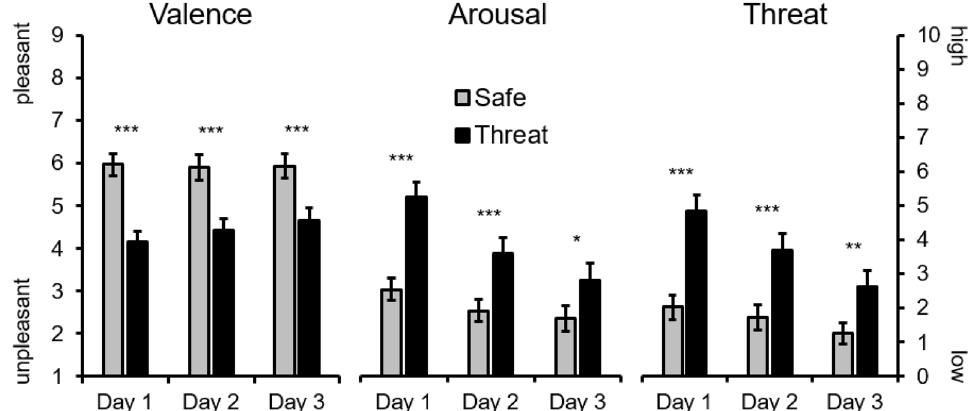
Figure 2. Self-reported valence, arousal and threat ratings show highly persistent effects of instructed threat compared to safety context across three test days (M and SEM, *** p < 0.001, ** p < 0.01, * p <